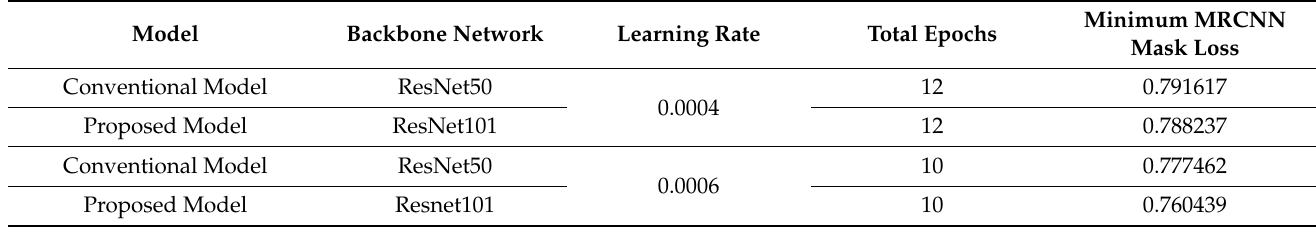
Table 9. MRCNN mask loss for validation data with different learning rates and epochs.